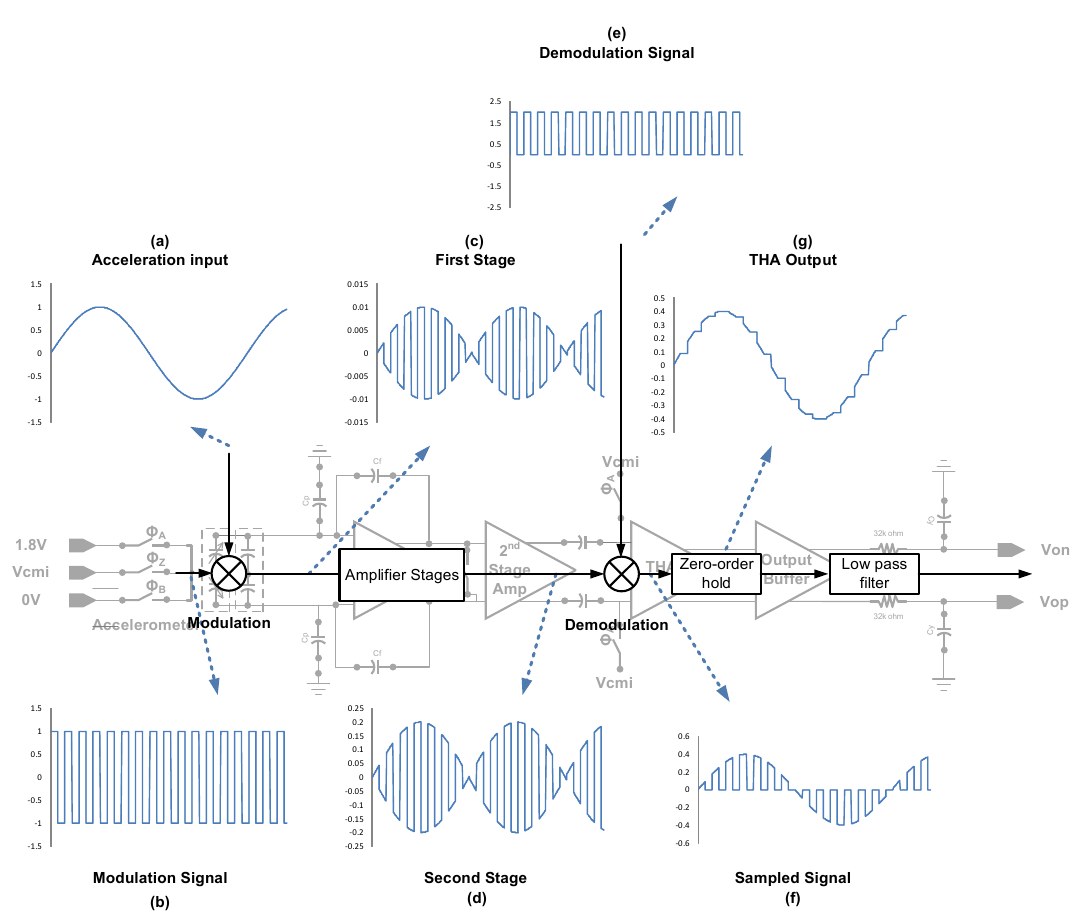
Figure 3. System function blocks with simplified modulation signal of the proposed readout circuit.